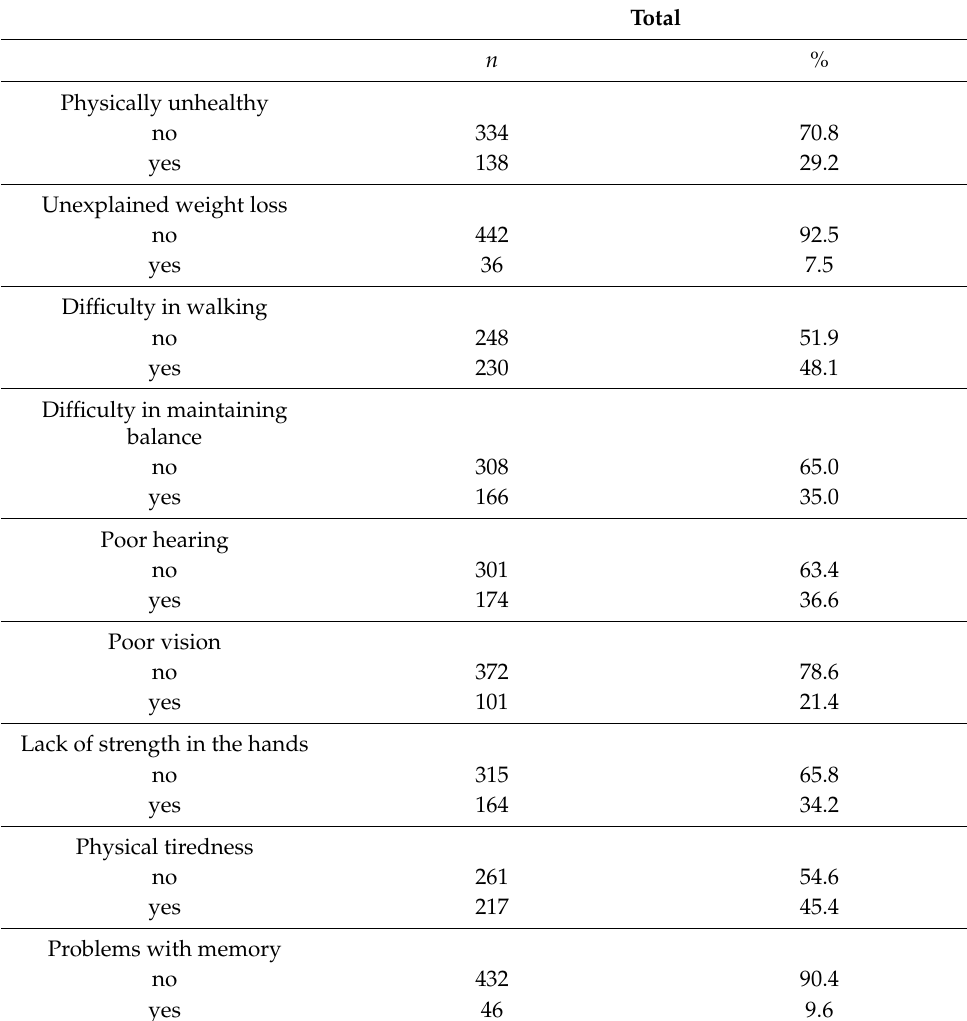
Table 3. Characteristics of the 15 TFI